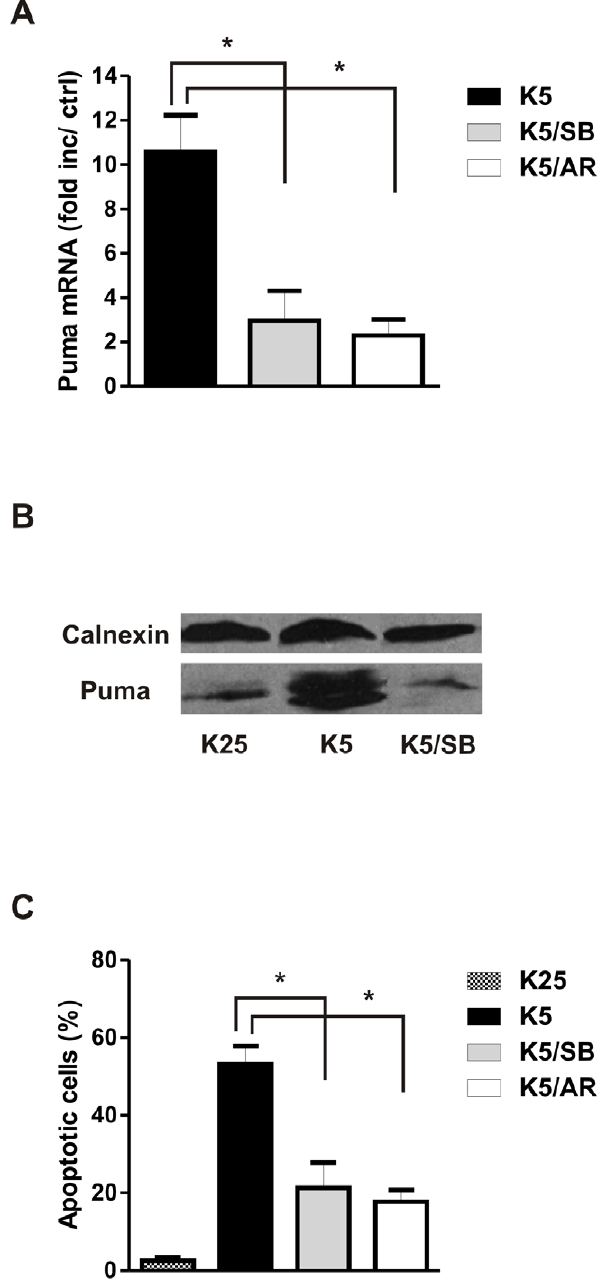
Figure 7. GSK3 b is required for Puma induction in potassium withdrawal induced apoptosis. CGNs were switched to low potassium medium in the presence or absence of the GSK3 a / b inhibitor SB415286 (SB, 30 m M) or the GSK3 b specific inhibitor AR-A01 4418 (AR, 50 m M). A, RNA was collected six hours after potassium withdrawal and analyzed for Puma mRNA expression using qRT-PCR (n=4, *p , 0.05). B, Protein extracts were collected 8 hours after potassium withdrawal and Puma protein levels were analyzed by western blot. C, The fraction of apoptotic neurons was quantified after 24 hours by Hoechst staining (n=3, *p , 0.05).